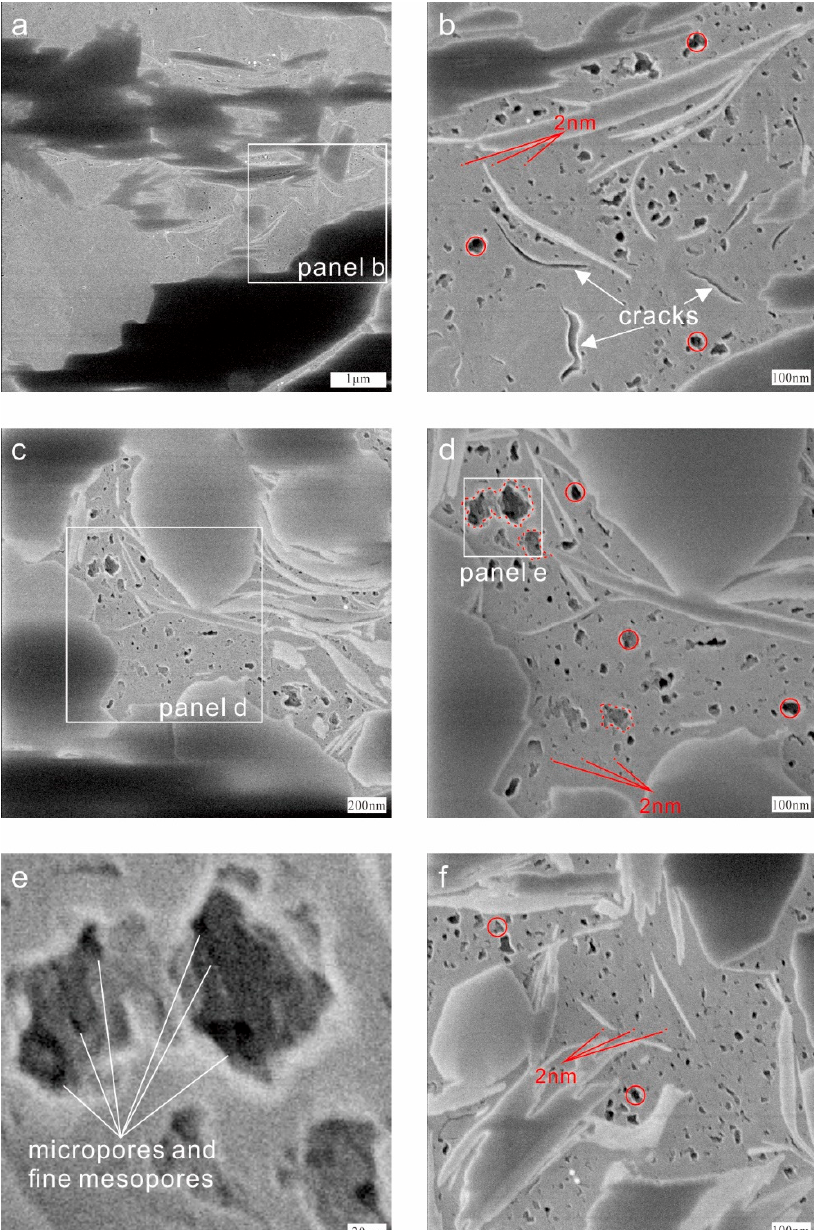
Figure 10. Helium ion microscope (HIM) images of sample L-2, showing abundant porosity with a wide range in the size of coarse mesopores and macropores. ( a )( b ): Many cracks caused by shrinkage can be obtained within the organic matter; ( c )( d ): The organic matter mixed with clay minerals and brittle minerals. There are some small pores developing at the walls of larger pores (circled by a red dashed line); ( e ): Many micropores and fine mesopores on the inner walls of macropores; ( f ): Well-developed organic pores, most of which are coarse mesopores.